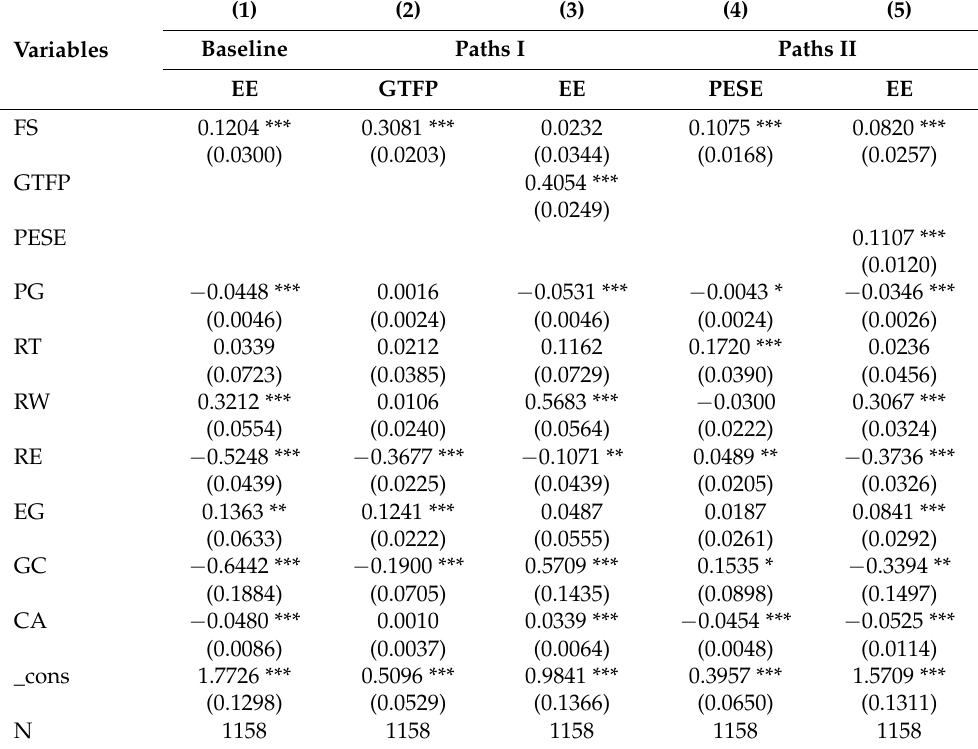
Table 10. Analysis of mediating effect—Green Production and Public Environmental